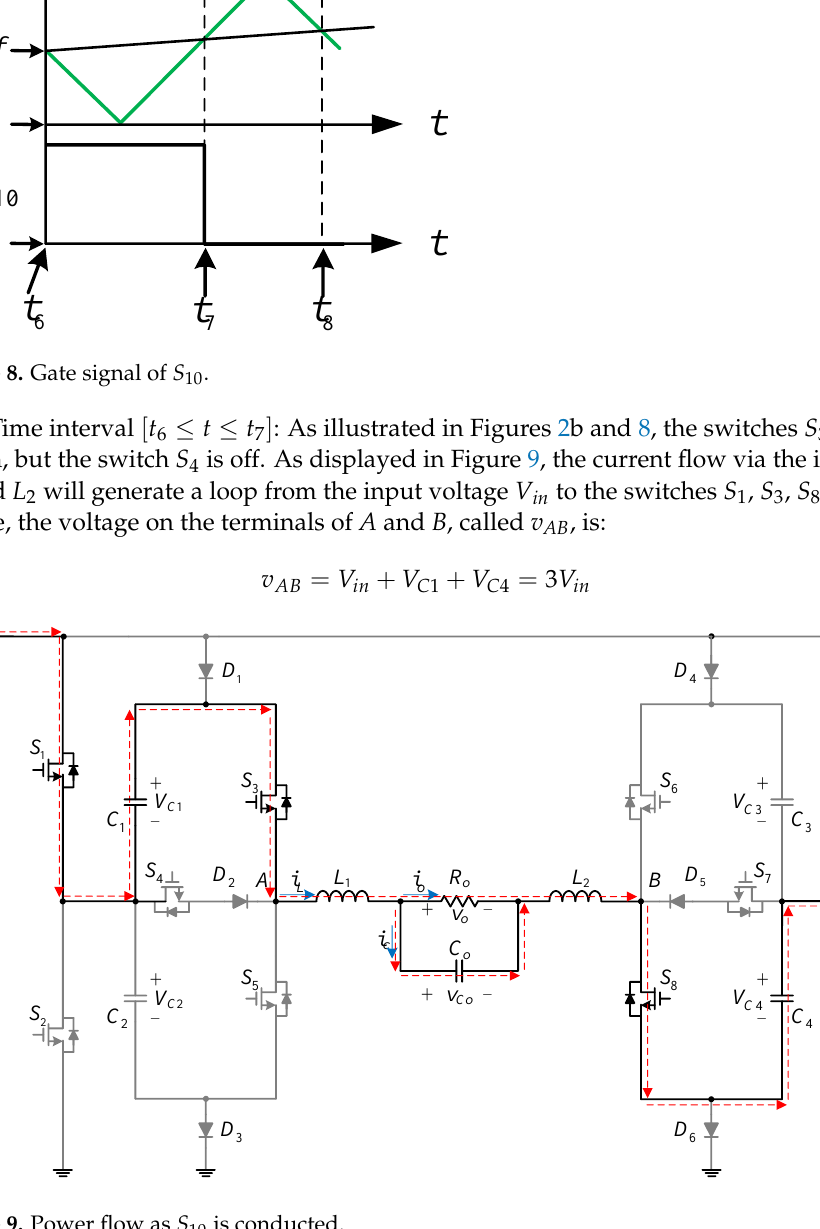
Figure 9. Power flow as S 10 is conducted.